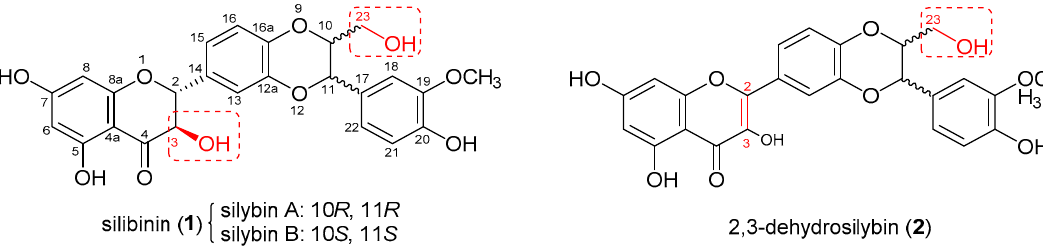
Figure 1. Chemical structures of silibinin ( 1 ) and 2,3-dehydrosilybin ( 2 ).